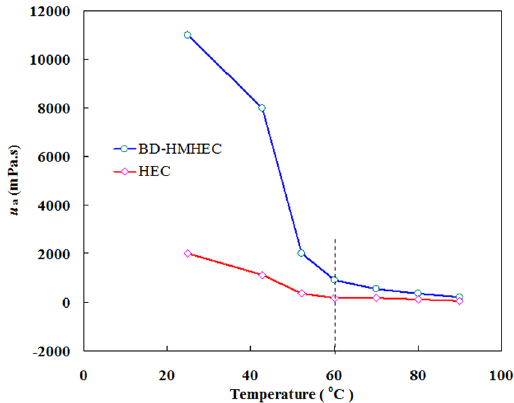
Figure 4. Effect of temperature on u a of BD-HMHEC and HEC solutions.